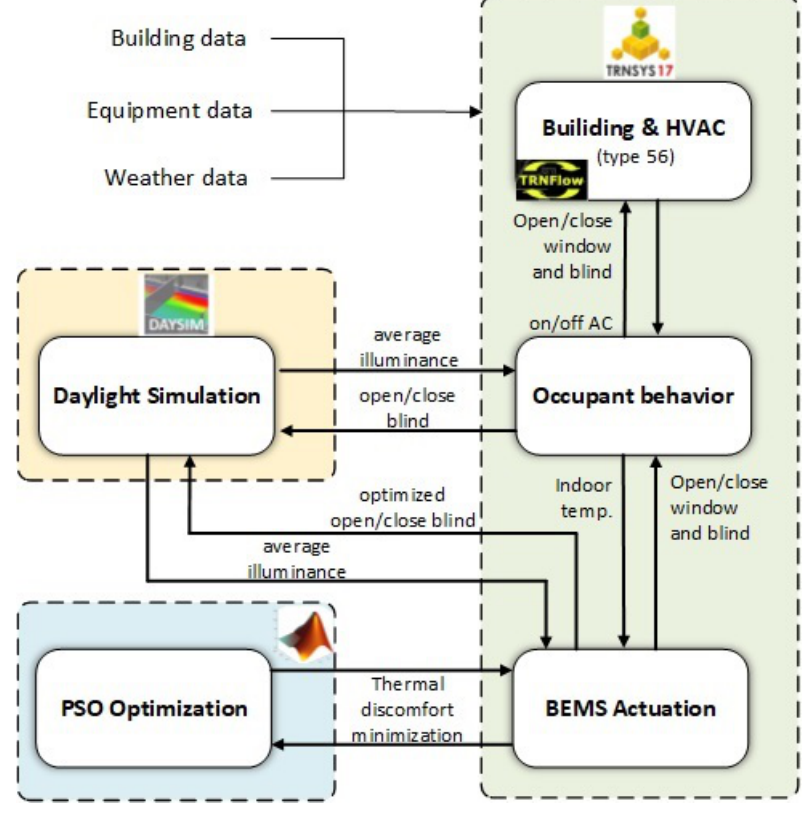
Figure 1. The co-simulation